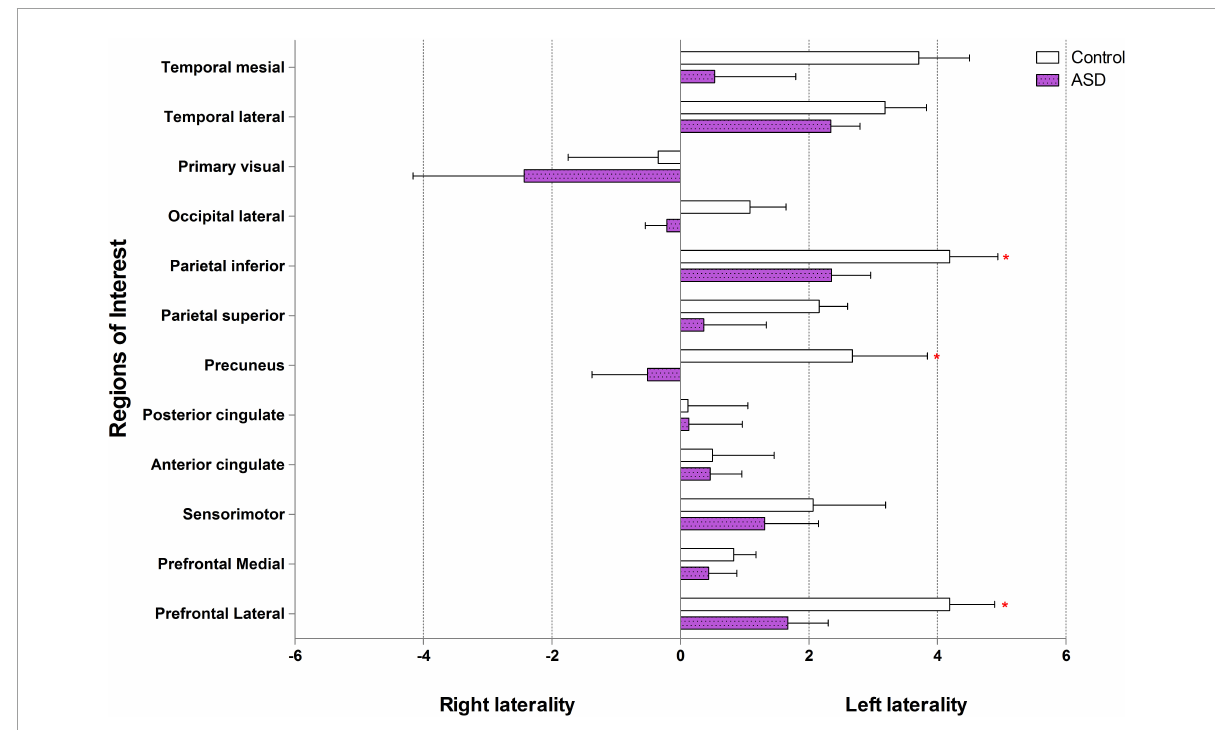
FIGURE3 Brain laterality in regions of interest between control and ASD ( * represents statistically significant by Wilcoxon signed-rank test).